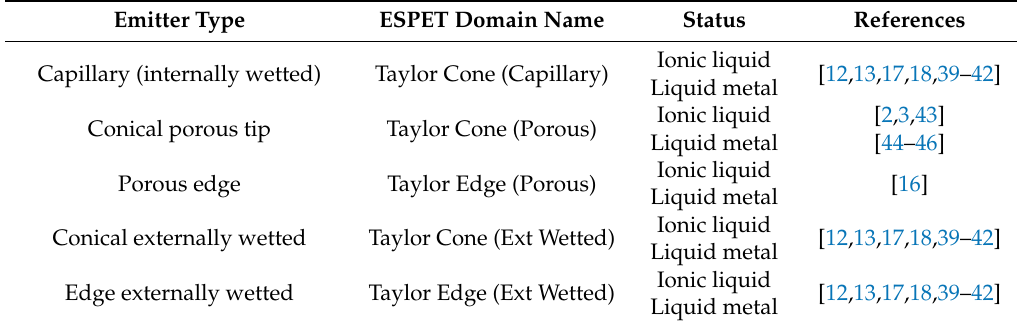
Table 4. Emitter types currently available in ESPET.